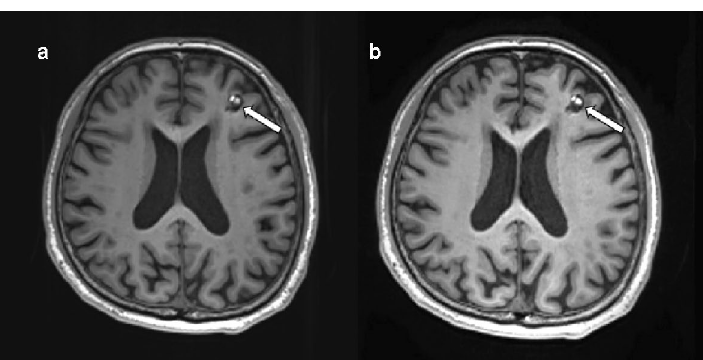
Figure 4. Cavernous malformation on conventional and wave-CAIPI MPRAGE. A 64-year-old man who had an approximately 1-cm characteristic popcorn-shaped mass with T1 high signal intensity and hemosiderin rim in the left frontal lobe, suggestive of cavernous malformation. It is well demarcated on both conventional pre- contrast 3D T1 MPRAGE ( a ) and wave-CAIPI MPRAGE ( b ). MPRAGE magnetization-prepared rapid gradient echo, wave-CAIPI wave-controlled aliasing in parallel